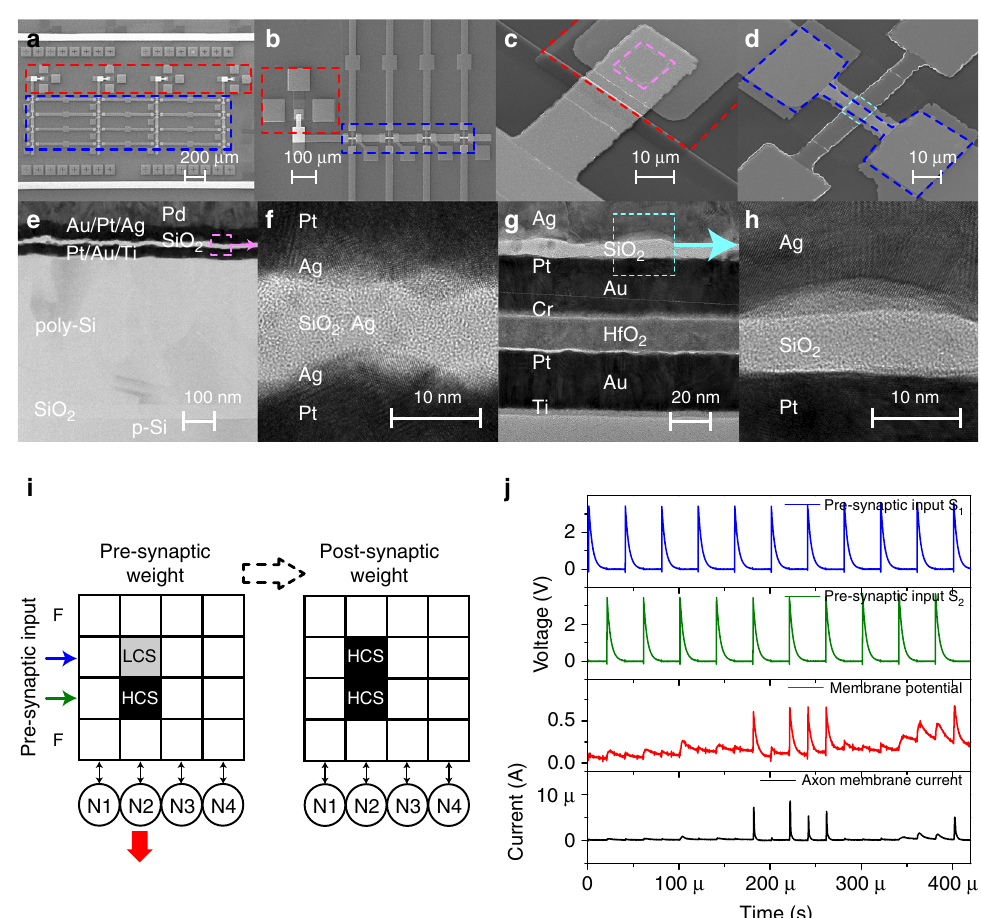
Fig. 4 Prototypical fully integrated capacitive neural network. a The scanning electron micrographs of the network consisting of a 4 × 4 crossbar array of synapses (blue box) linked with four neurons (red box). b Each neuron was interfaced to four synapses. c , d The DPM neurons and the NPM synapses were both built utilizing Ag-based memristors (magenta and cyan boxes, respectively) in series with integrated capacitors (red and blue boxes). e Structural analysis of the neuro-transistor. The cross-sectional transmission electron micrograph shows the diffusive memristor sitting on the gate of a convention n-MOSFET. f The high-resolution transmission electron micrograph of the diffusive memristor showing the amorphous SiO x dielectric matrix with nano-crystalline thin Ag layers. g Structural analysis of the integrated synapse. The transmission electron micrograph shows the electrochemical metallization cell on top of a HfO 2 capacitor. h The zoomed high-resolution transmission electron micrograph of the electrochemical metallization cell shows the thick Ag electrode responsible for the longer retention time of the high conductance state of the memristor. i , j Schematic illustration and experimental observation of the synapse programming using the Hebbian-like mechanism. Simultaneous pre-synaptic signals (blue and green lines in j ) were applied to both the low capacitance state (LCS) synapse and the high capacitance state (HCS) synapse. The post-synaptic neuron fi red (red lines in j ) and the LCS synapse was subsequently potentiated, which made the neuron fi re within a shorter integration time from 280 to 400 μ s (red curve of